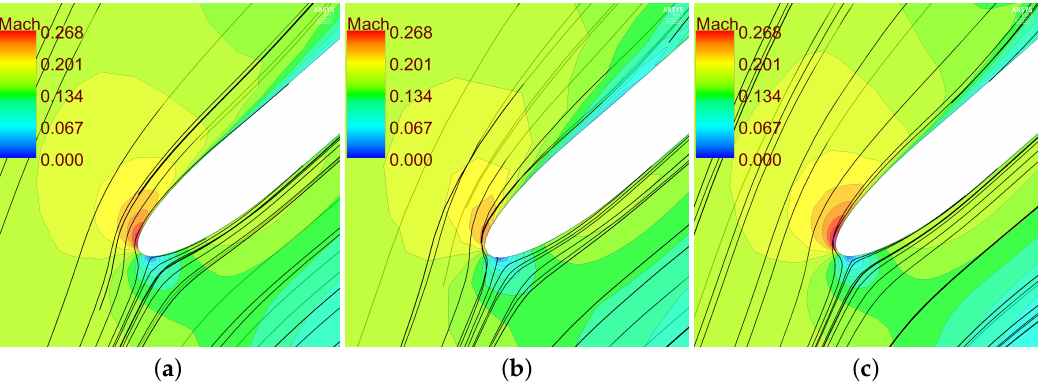
Figure 13. Streamlines near leading edge of the main blade on the relative Mach number contour at a mass flow rate of 3.2 kg/s. ( a ) Impeller alone. ( b ) Impeller with vaneless diffuser. ( c ) Impeller with vaned diffuser.